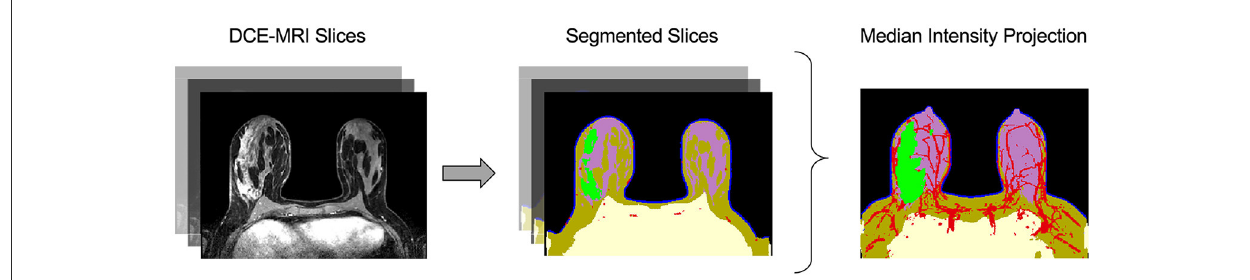
FIGURE2 Automatic image segmentation of breast DCE-MRIs performed by artificial intelligence. The segmentation model uses a convolutional neural network (CNN) to identify and segment tissues based on multiple DCE-MRI slices (left) . The tissue categories of the segmentation are: air (black), chest (yellow), skin (blue), fat (brown), gland (purple), vasculature (red), and tumor (green), shown at center. The median intensity projection across all segmented layers is shown at right .